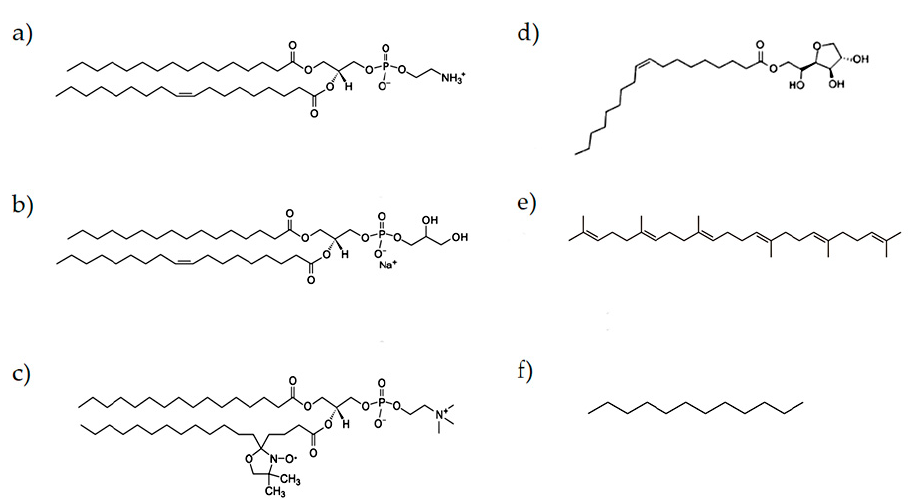
Figure 1. Molecular formulae of ( a ) POPE, ( b ) POPG, ( c ) 5-PCSL (chosen as an example of spin label) ( d ) Span 80, ( e ) squalene and ( f ) dodecane.